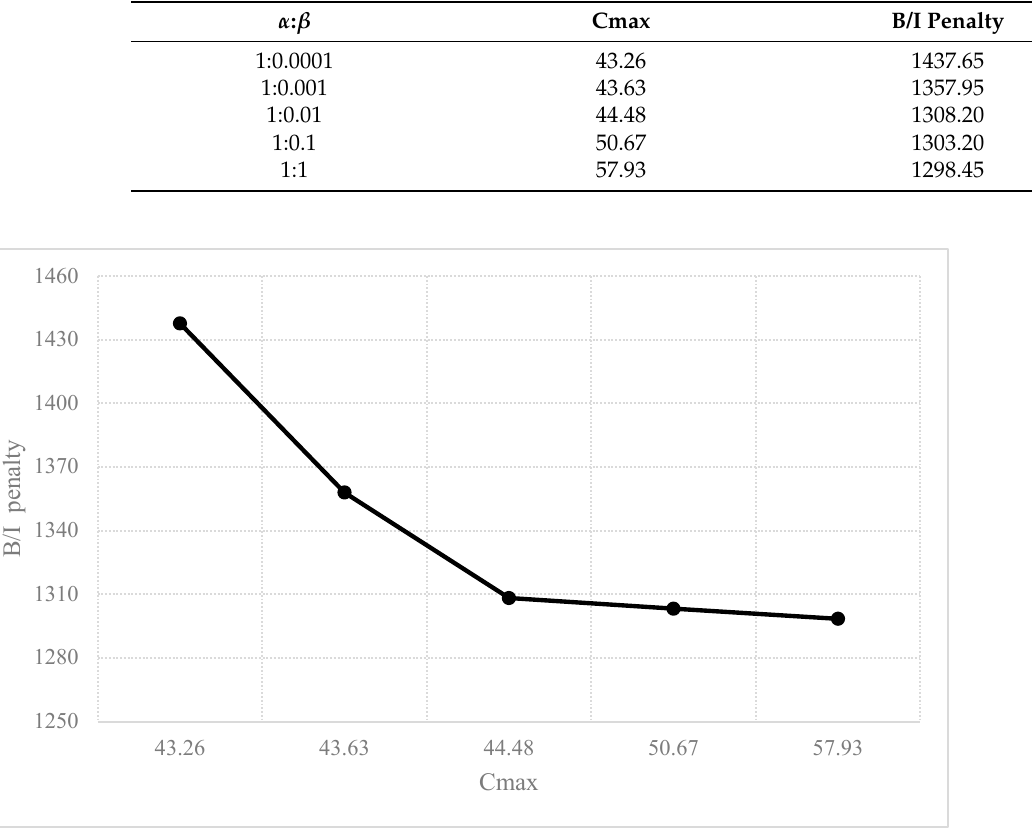
Figure 3. The tradeoff between Cmax and the burn-in (B/I) penalty. Figure 6. The tradeoff between Cmax and the burn-in (B/I)